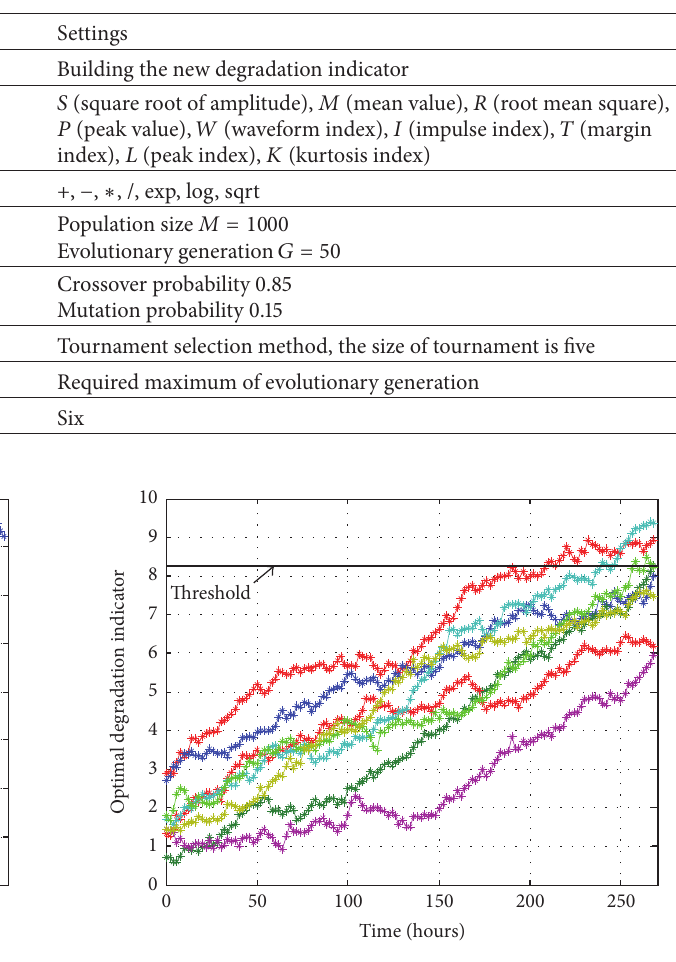
Figure 12: Optimal degradation indicator. Figure 13: Calculated optimal degradation indicator data of eight